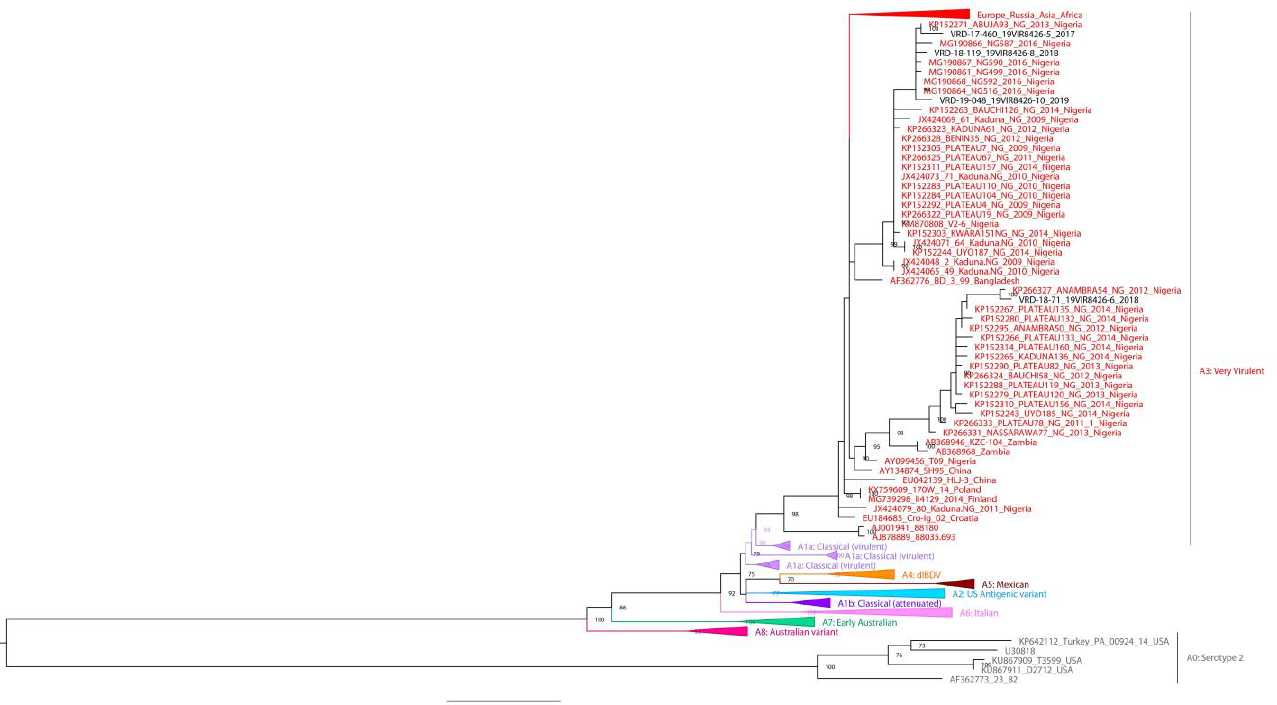
Figure 2. Phylogenetic tree of nucleotide sequences of partial segment A of IBDV based on VP2 hy- pervariable region. Maximum likelihood method with the best-fit model (SYM+I+G4) automatically identified by IQ-TREE v.1.6.12. All genogroups except A3 and A0 have been collapsed. The samples generated in the study are identified in black. The ultra-fast bootstrap values higher than 70% are indicated near the